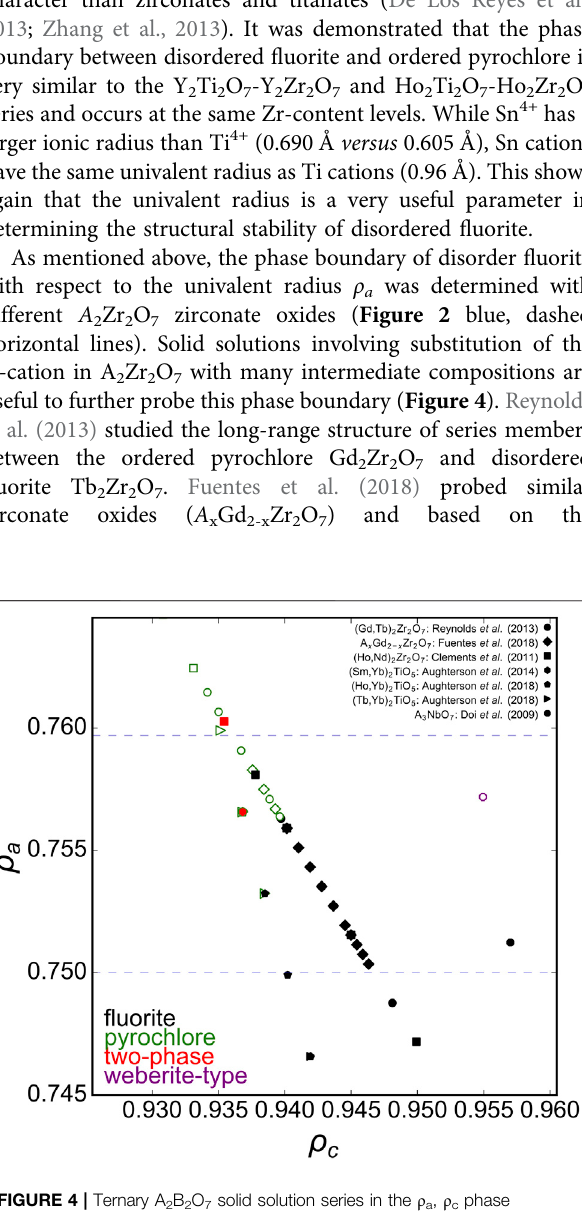
FIGURE 4 | Ternary A 2 B 2 O 7 solid solution series in the ρ a , ρ c phase space with ρ a boundaries (blue dashed horizontal lines) established from A 2 Zr 2 O 7 compositions ( Figure 2 ). Experimental data points represented by diamonds taken from Fuentes et al. (2018), circles from Reynolds et al. (2013), squares from Clements et al. (2011), hexagons from Aughterson et al. (2014), pentagons from Aughterson et al. (2018a), triangles from Aughterson et al. (2018b), and octagons from Doi et al. (2009). Solid black squares represent disordered fl uorite, open green squares pyrochlore, and solid red squares a mix of